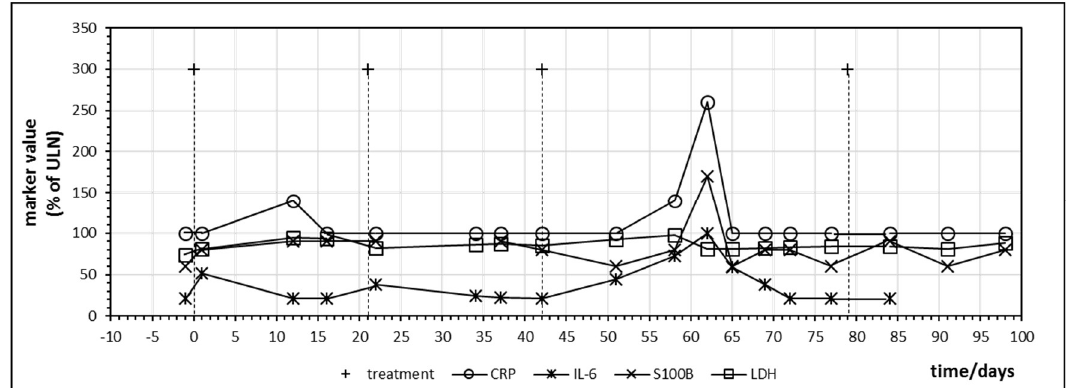
Figure 3. Time course of immune markers c-reactive protein (CRP) and IL-6 and tumor markers S100B and lactate dehydrogenase (LDH) during checkpoint inhibitor treatment starting at day 0. Patient no. 1, four cycles of ipilimumab, delay in the administration of the fourth cycle was due to gastral bleeding.